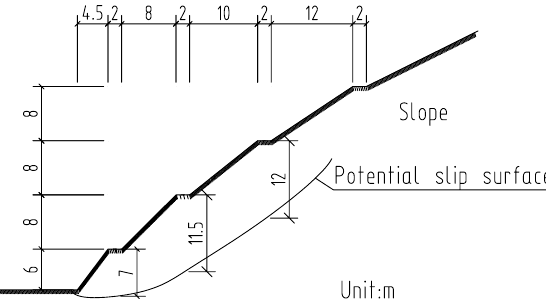
Figure 19. Depth of potential slip surface of Lijiazhai slope.